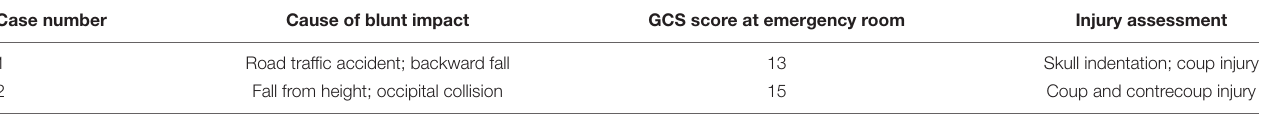
TABLE 2 | Clinical assessment of brain injury due to fall